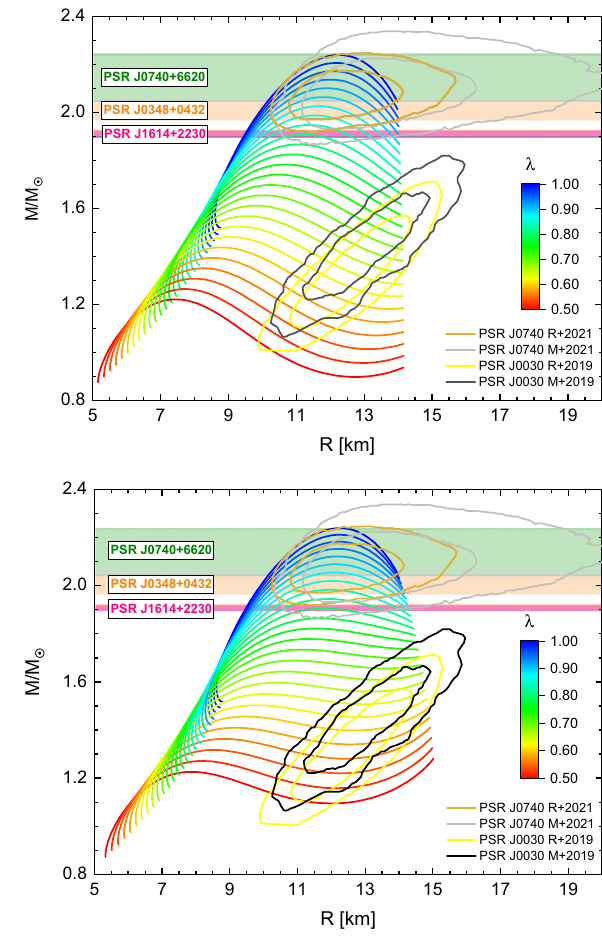
Fig. 6 Top: dimensionless tidal deformability Λ as a function of the total mass in solar masses. The vertical dash-dot-dot line marks the tidal deformability of event GW170817 estimated in [57]. Bottom: the dimensionless tidal deformability Λ 1 and Λ 2 for a binary NS system withmasses m 1 and m 2 andthesamechirpmassastheeventGW170817 [9]. We only take into account the combination with m 1 > m 2 . The diagonal short dot line denotes the Λ 1 = Λ 2 limit. The solid top yellow line indicates the 90% credibility level and the bottom yellow solid line is the 50% level established by LIGO-Virgo scientific network in the low-spin prior scenario. Only stable equilibrium configurations with slow conversions at the interface are shown